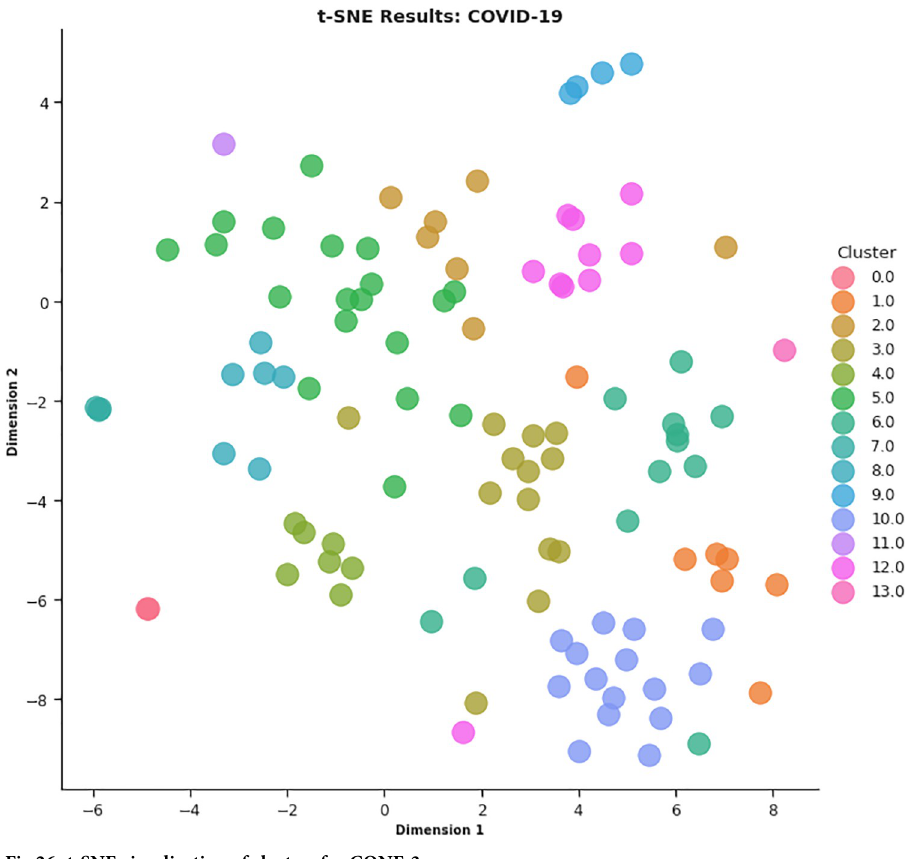
Fig 26. t-SNE visualization of clusters for